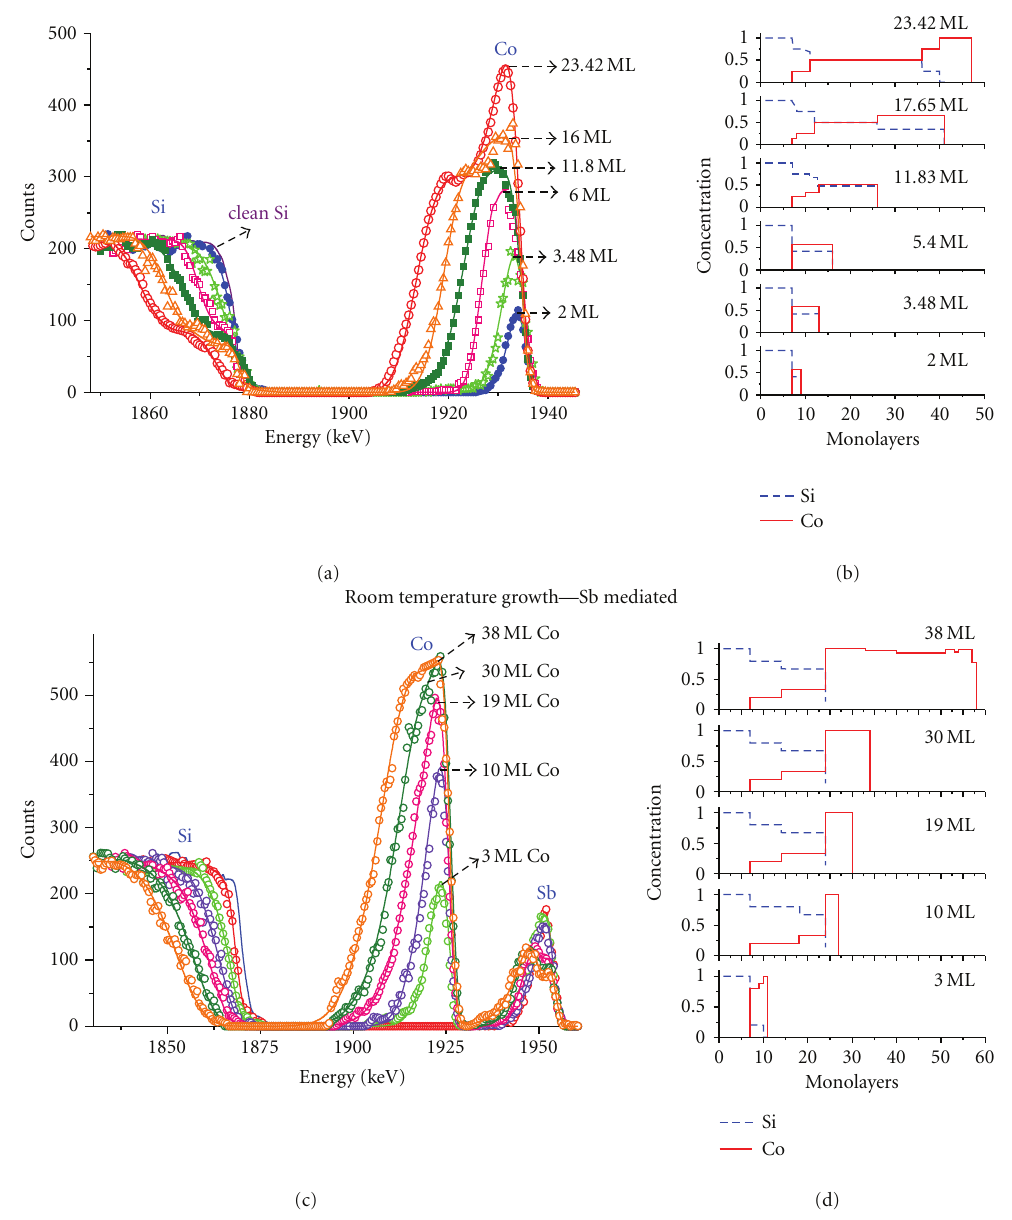
Figure 4: Co on Si, higher coverage ( ≥ 2 ML). Panels at left-hand side: Co and Si (and Sb) HRBS spectra (circles) and RUMP simulations (solid lines). Panels at the right-hand side: Co and Si concentrations as derived by RUMP (depth scale: monolayers of Si, each 6 . 87 · 10 14 at./cm 2 thick). The right-hand side of the concentration profiles corresponds to the free surface of the samples. (a) Co deposition at RT. (b) Co and Si concentration profiles derived from (a). (c) Surfactant-mediated deposition of Co at RT. (d) Co and Si concentration profiles derived from (c). The right-hand side of the concentration profiles corresponds to the surface of the Co/Si samples (which in case of the Sb-mediated deposition is below an Sb layer). Layer 0 was deliberately put into the Si